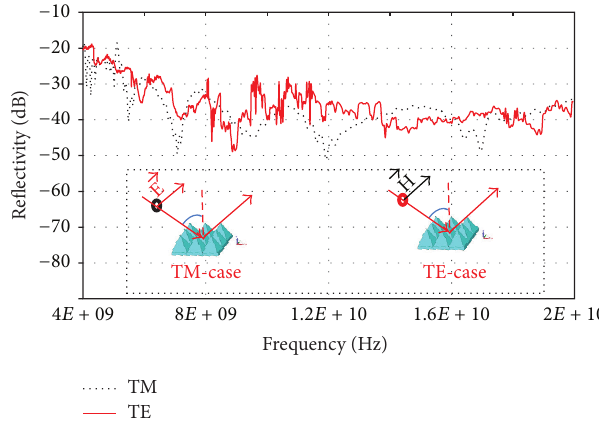
Figure 12: Oblique angle reflectivity performance of the rice husk- based,hollowpyramidalstructuresinTMandTEpolarizationat45 ∘ incident